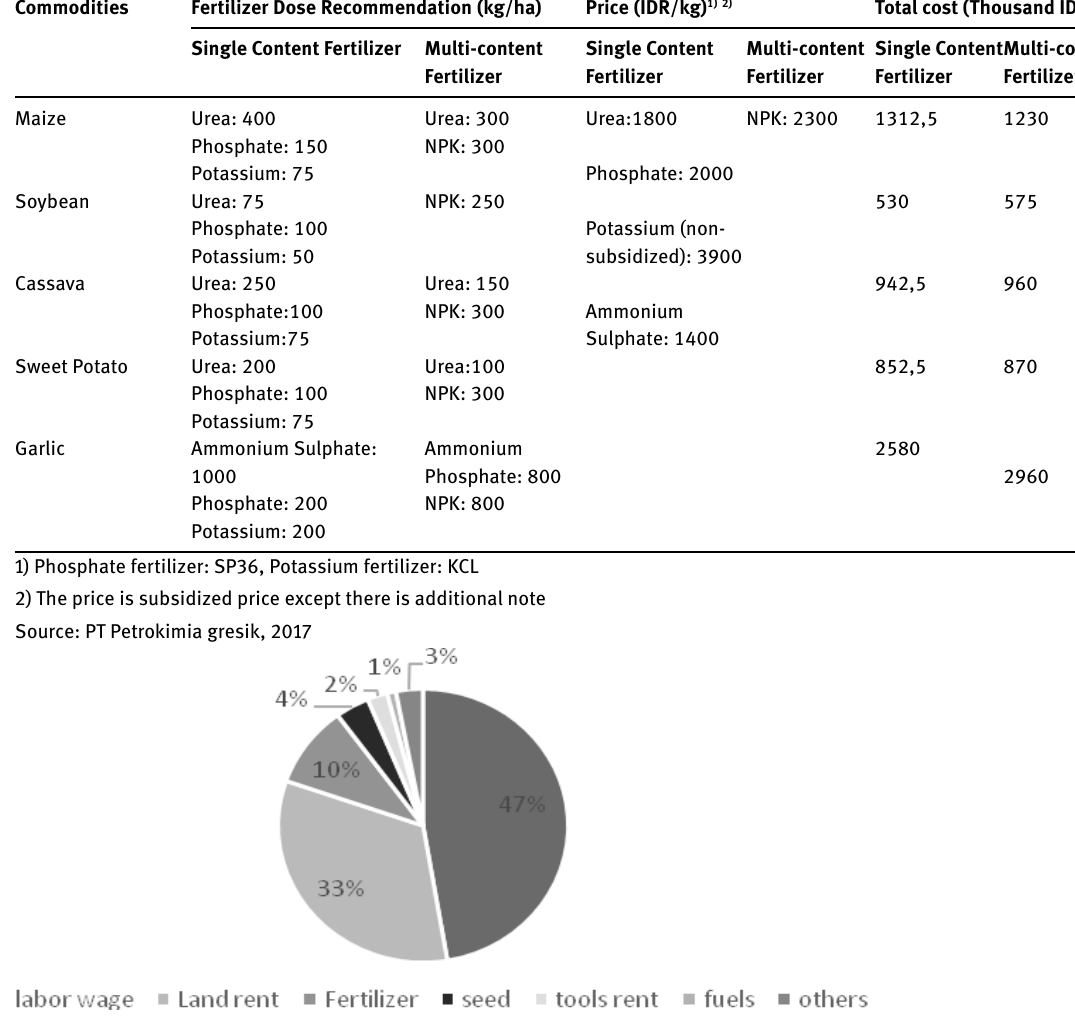
Figure 5: Farmers Expenditure Structure. Source: Indonesia Statistic Bureau